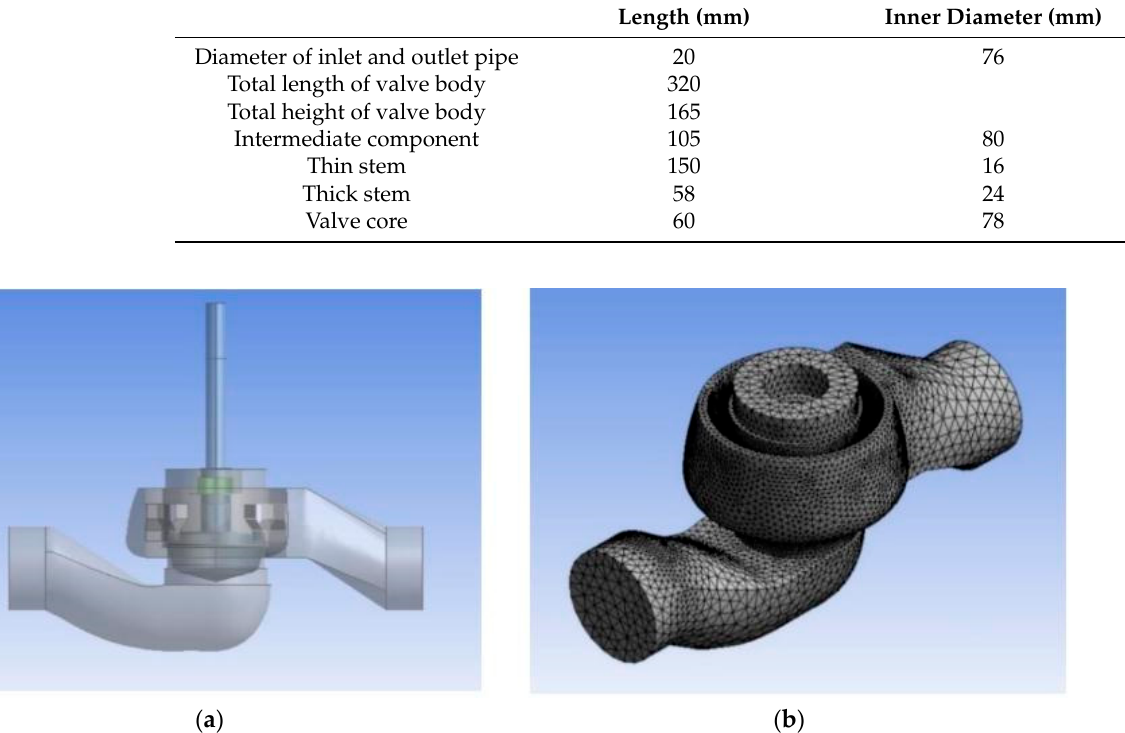
Figure 7. Regulating valve model and grid model diagram; ( a ) Regulating valve model; ( b ) Grid of overall flow channel model.